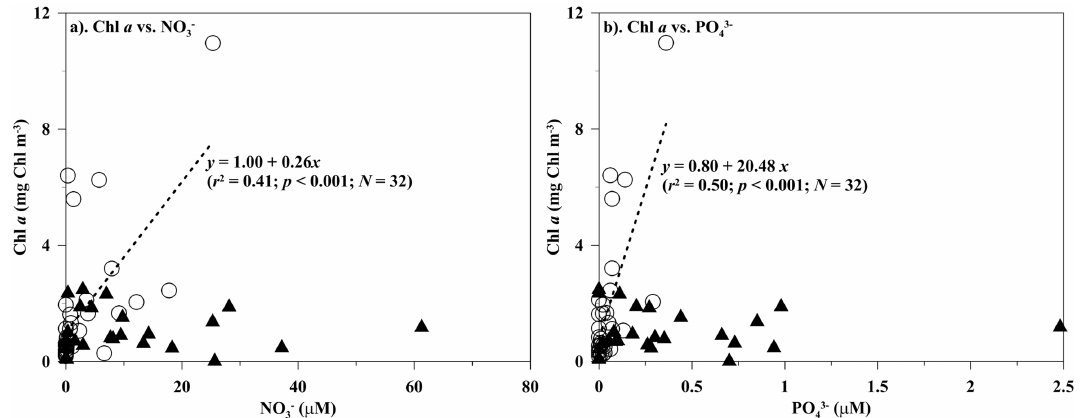
) and (b) phosphate (PO 3 − ) of the surface waters in the spring of 3 4